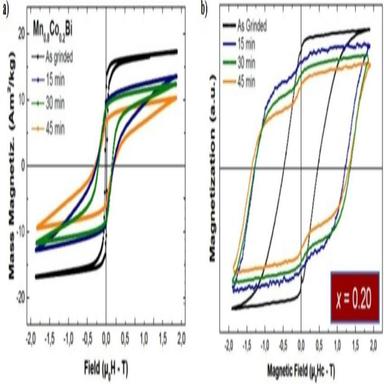
.a) Hysteresis loops of Mn0.8Co0.2Bi powder for various ball milling times, from 0 to 45 min, b) Hysteresis loops of the same orientated samples.